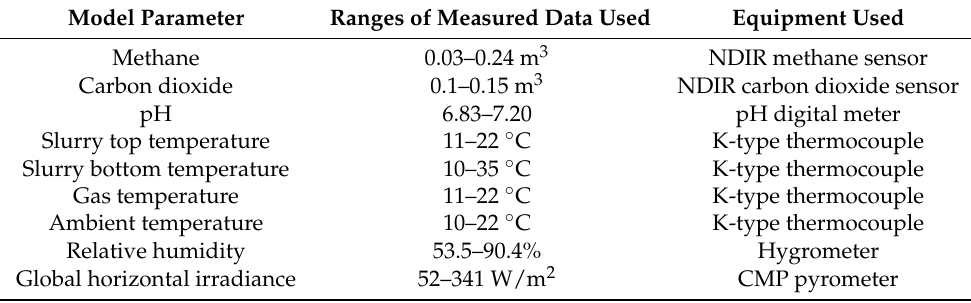
Table 4. Data and equipment used for